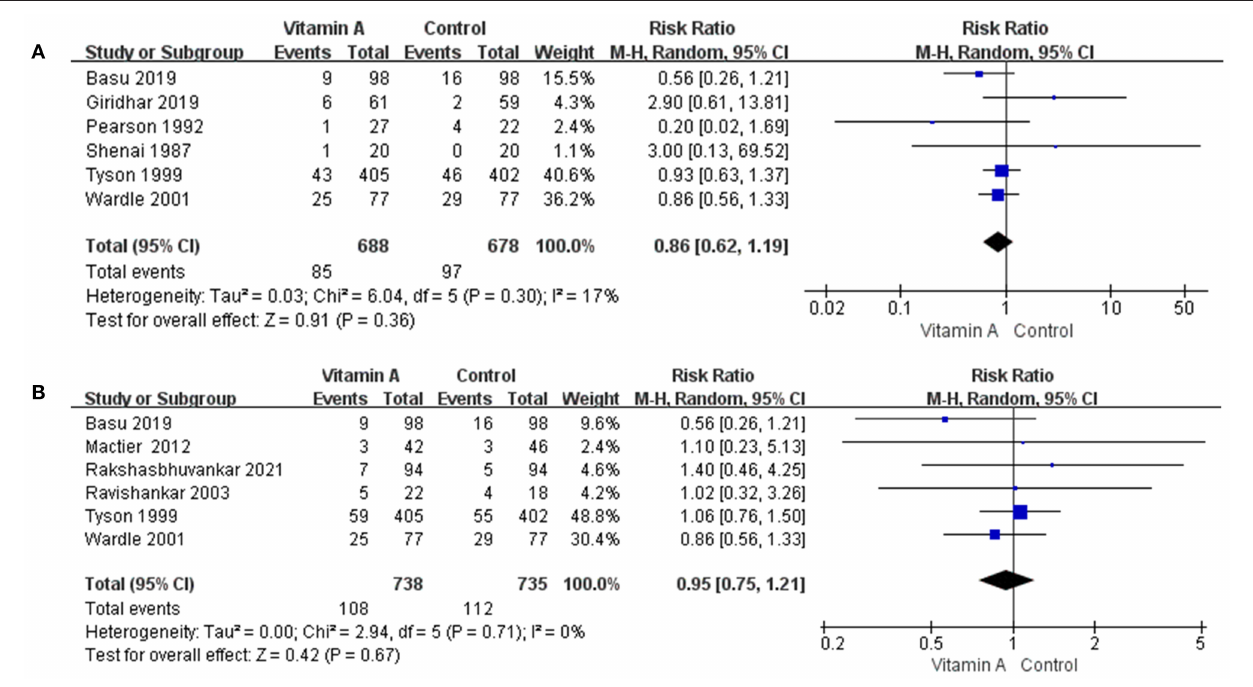
FIGURE 4 | The forest plot for the incidences of mortality. (A) The forest plot for the incidence of death before 1 month. (B) The forest plot for the incidence of death at 36 weeks’ PMA.